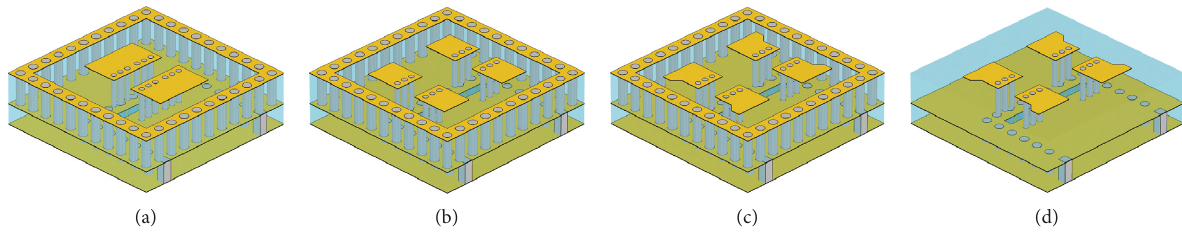
Figure 2: Configuration of the proposed different antenna element. (a) Reference ant. 1: SIW cavity-backed rectangle ME dipole antenna. (b) Reference ant. 2: modified SIW cavity-backed rectangle ME dipole antenna. (c) Proposed ant. 3: the proposed modified SIW cavity- backed bowtie ME dipole antenna. (d) Reference ant. 4: comparison of ME dipole antenna without SIW